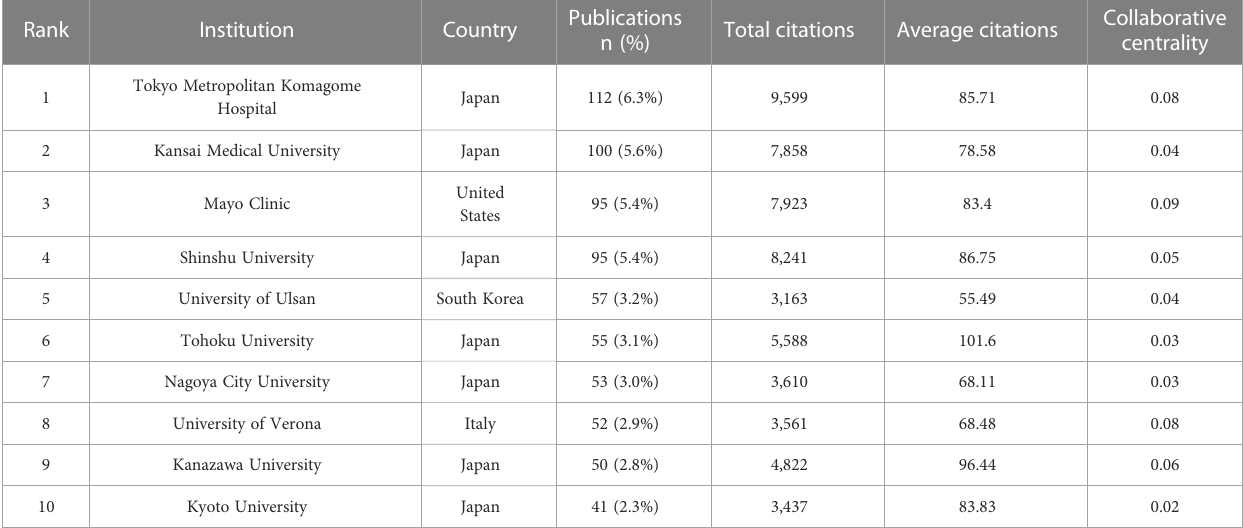
TABLE 2 The top 10 most productive institutions in terms of AIP research.